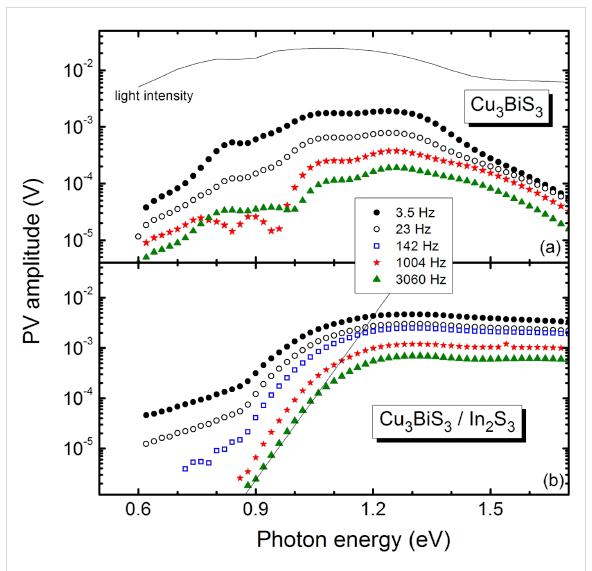
Figure 5: PV amplitude spectra of (a) Cu 3 BiS 3 and (b) Cu 3 BiS 3 /In 2 S 3 at modulation frequencies between 3.5 and 3060 Hz. The solid curve in the upper panel gives the light intensity. The straight line in the lower panel shows a fit to the data at 3060 Hz describing exponential tail states